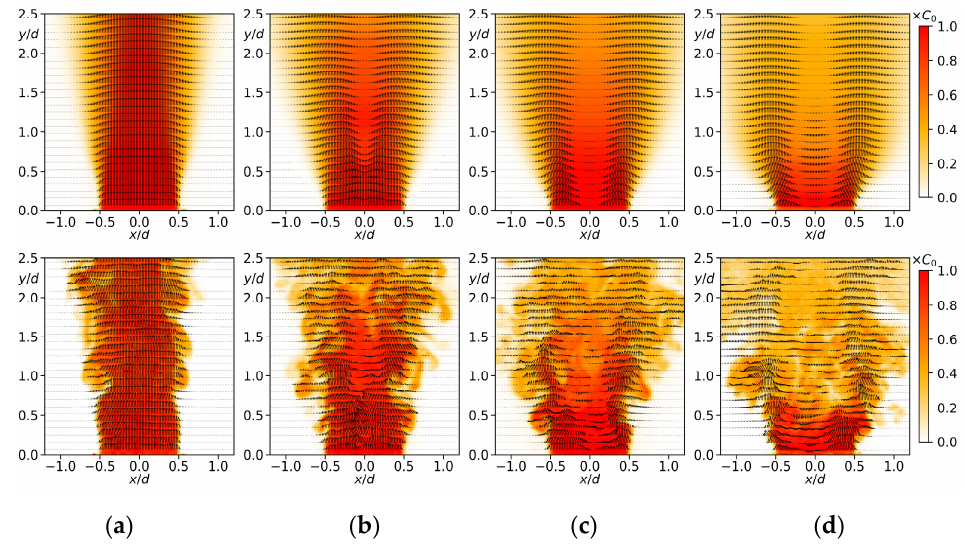
Figure 2. Mean and instantaneous concentration and velocity fields for jet flows: ( a ) S = 0, ( b ) S = 0.41, ( c ) S = 0.7, and ( d ) S = 1.0.